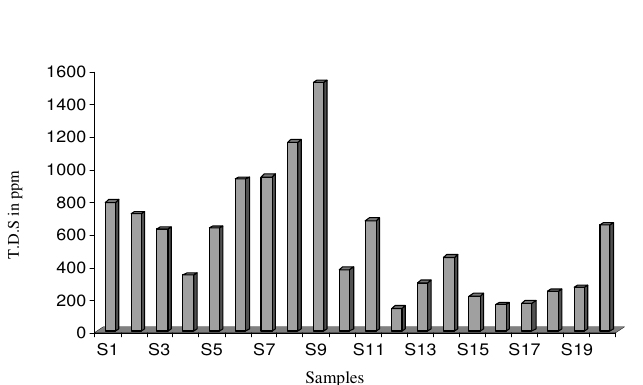
Figure 2. Total dissolved solids (ppm) of water samples collected from Kandarvakottai (S1 to S10) and Karambakudi (S11 to S20)